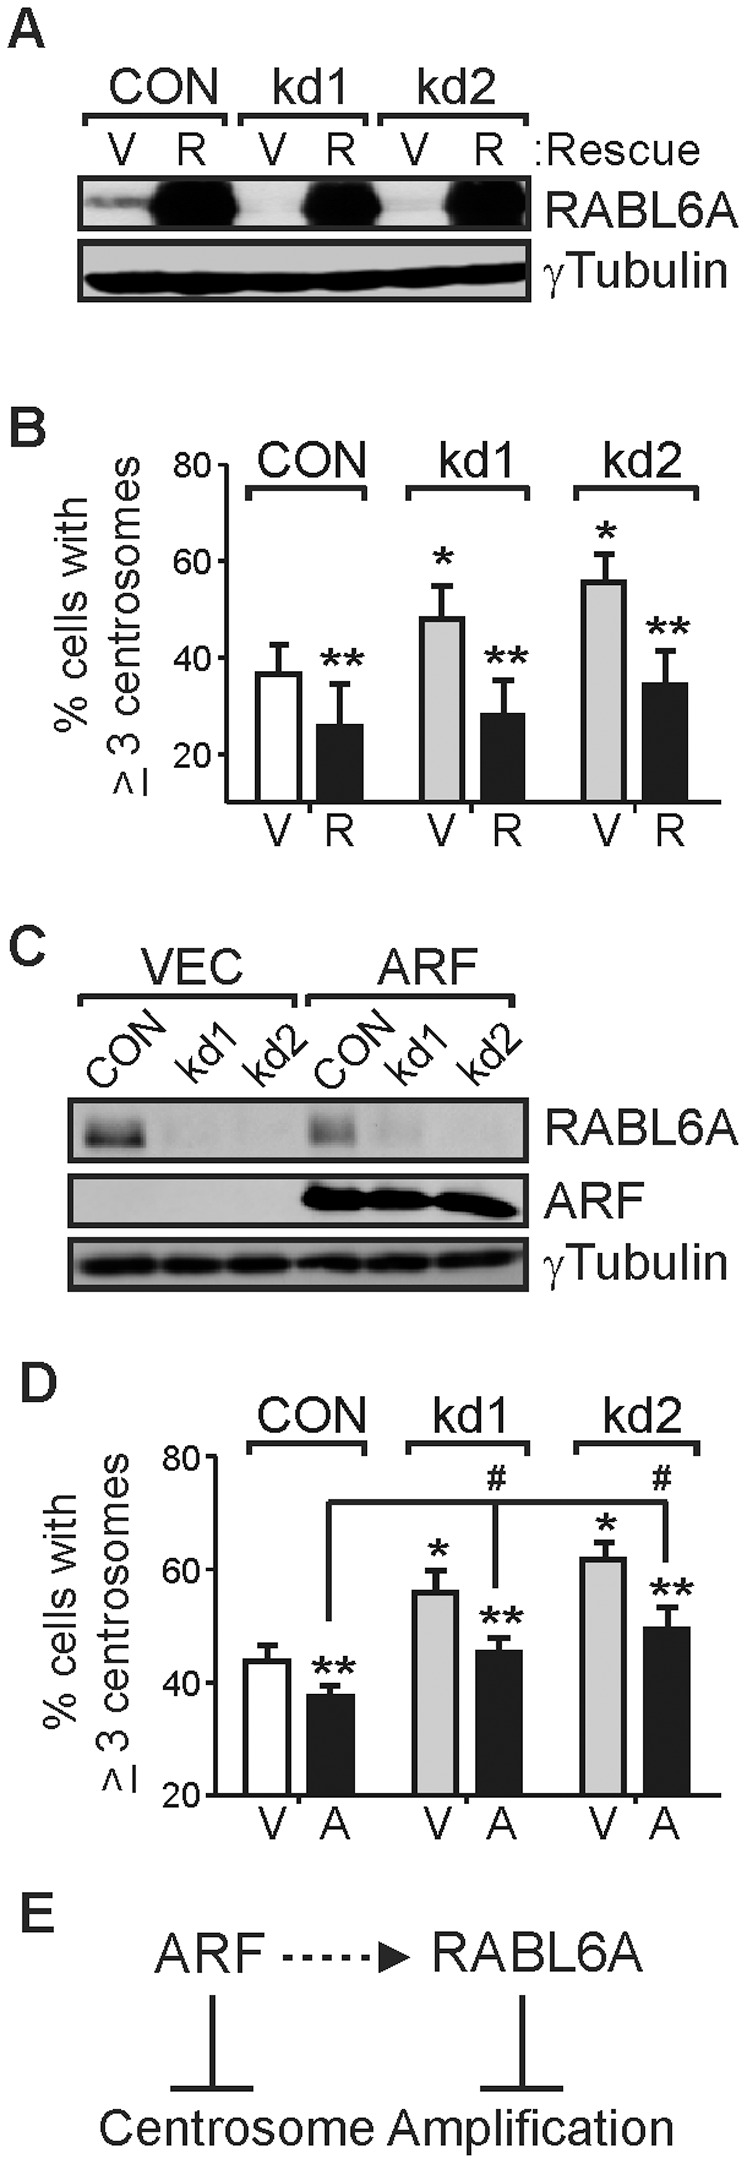
RABL6A inhibits centrosome amplification independent of ARF.(A) Immunoblot showing effective mouse RABL6A knockdown in kd1 and kd2 triple knockout (TKO) MEFs lacking p53, Mdm2 and ARF, as well as high level expression of human RABL6A (R) versus vector (V) in CON and kd cells. (B) Quantification of immunofluorescence data for centrosome amplification in cells from (A) from three or more separate experiments. *, p<0.01 compared to CON. **, p<0.05 for human RABL6A expressing cells versus vector controls. (C) Immunoblot showing effective mouse RABL6A knockdown in kd TKO MEFs and expression of exogenous mouse ARF in CON and kd cells. (D) Quantification of immunofluorescence data for centrosome amplification in cells from (C) from three separate experiments. *, p<0.01 compared to CON. **, p<0.05 for ARF (A) expressing cells versus vector (V) controls. #, p<0.05 for kd1 and kd2 versus CON cells expressing ARF (black bars). (E) Model showing RABL6A and ARF can act separately to inhibit centrosome amplification. The dashed arrow between ARF and RABL6A indicates ARF may suppress centrosome amplification, in part, through RABL6A. Statistical significance for data in panels B and D was determined using paired, two-tailed Student’s t-test.